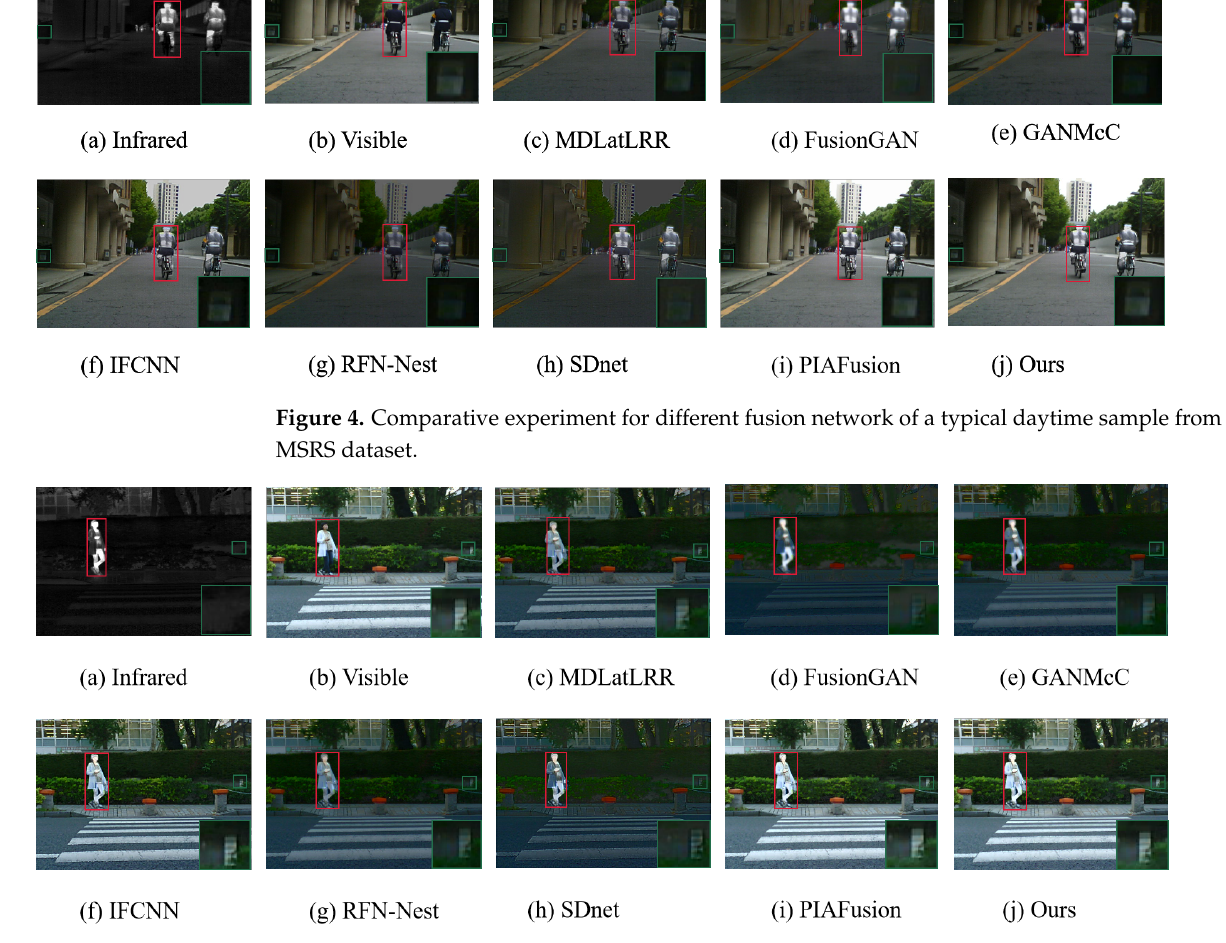
Figure 5. Comparative experiment for different fusion network of a typical daytime sample from the MSRS dataset.